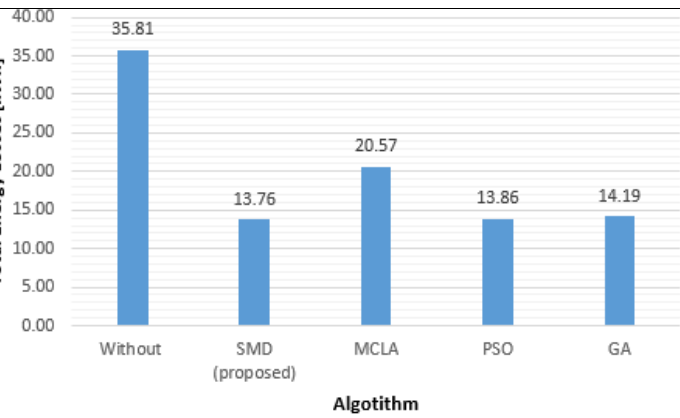
Figure 15. Comparison between the total energy losses, calculated with different algorithms.